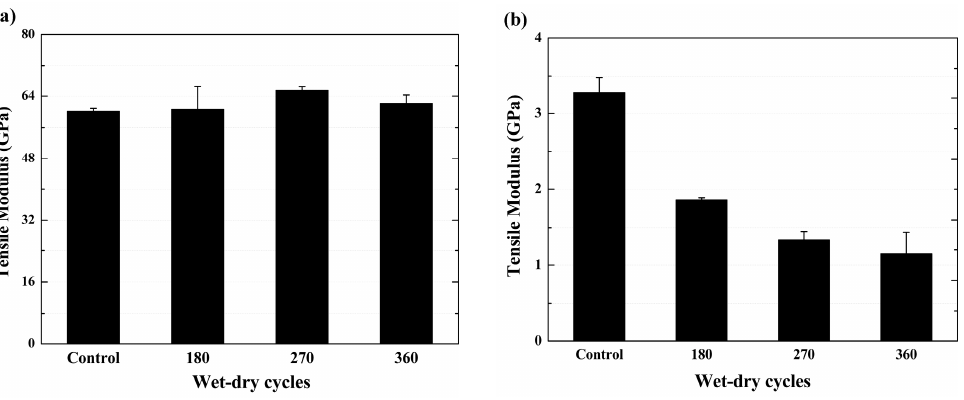
Figure 12. Tensile modulus of the specimens as a function of wet–dry cycles, ( a ) BFRP sheet; ( b ) epoxy resin matrix. resin